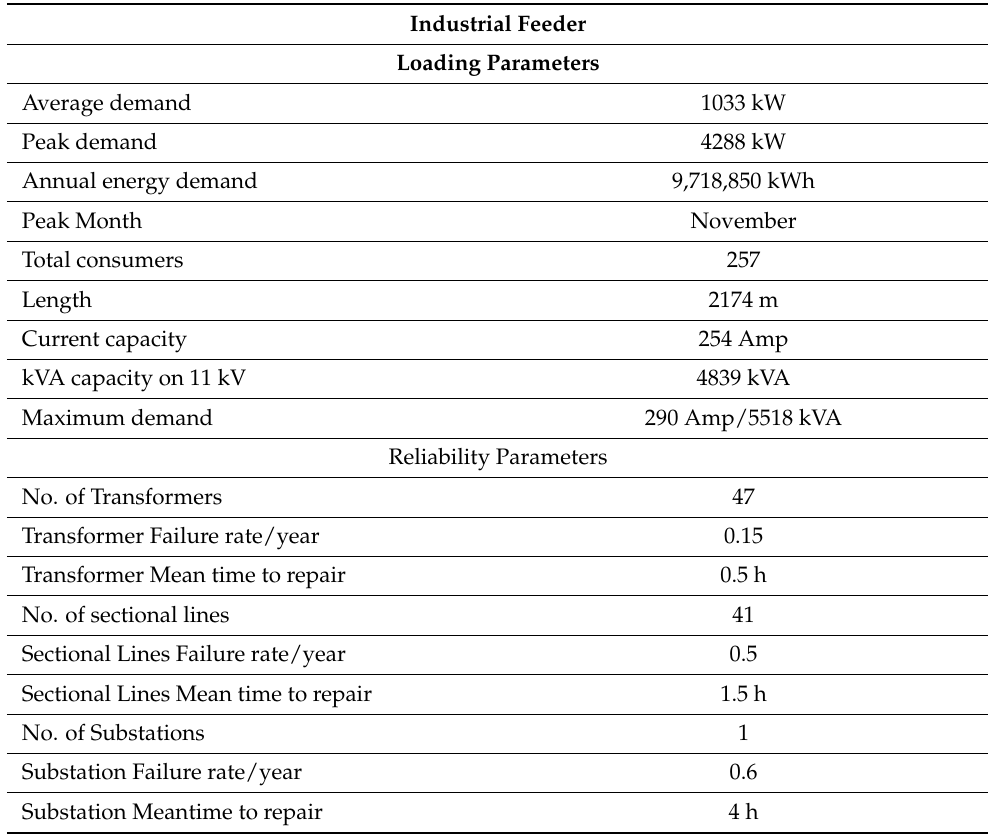
Table 1. PSPCL Load and Reliability data.